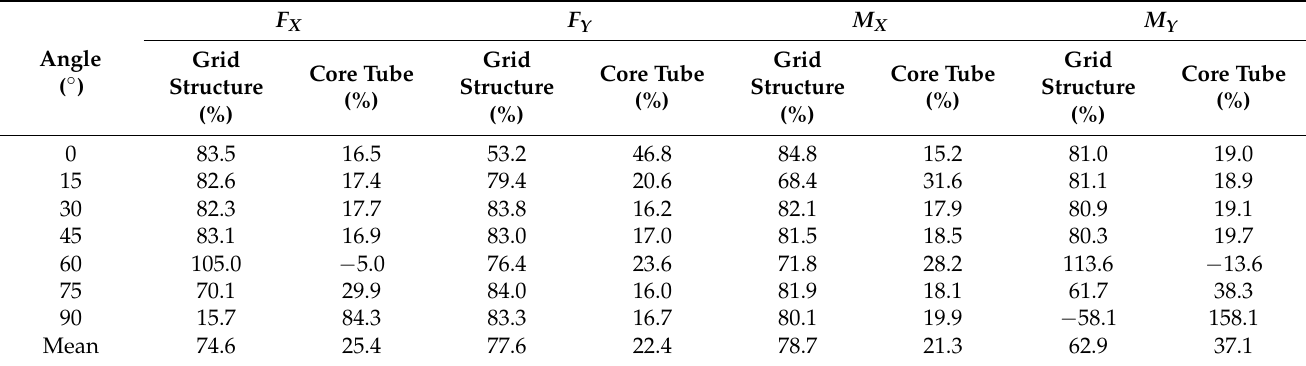
Table 4. Percentage of wind load of the grid structure and core tube in the total wind load.